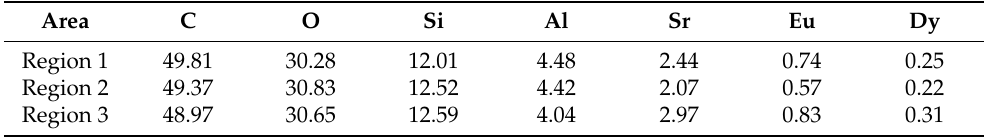
Table 1. EDX of S 8 at three distinct sites on cotton